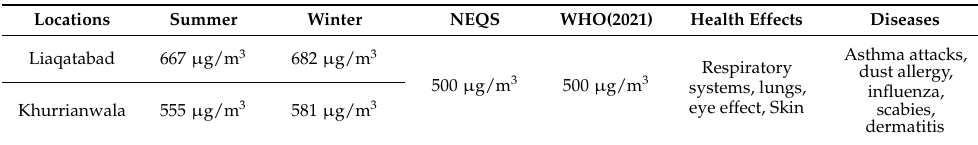
Table 4. Seasonal variation of SPM at selected sites in comparison to NEQS and WHO and corre- sponding health